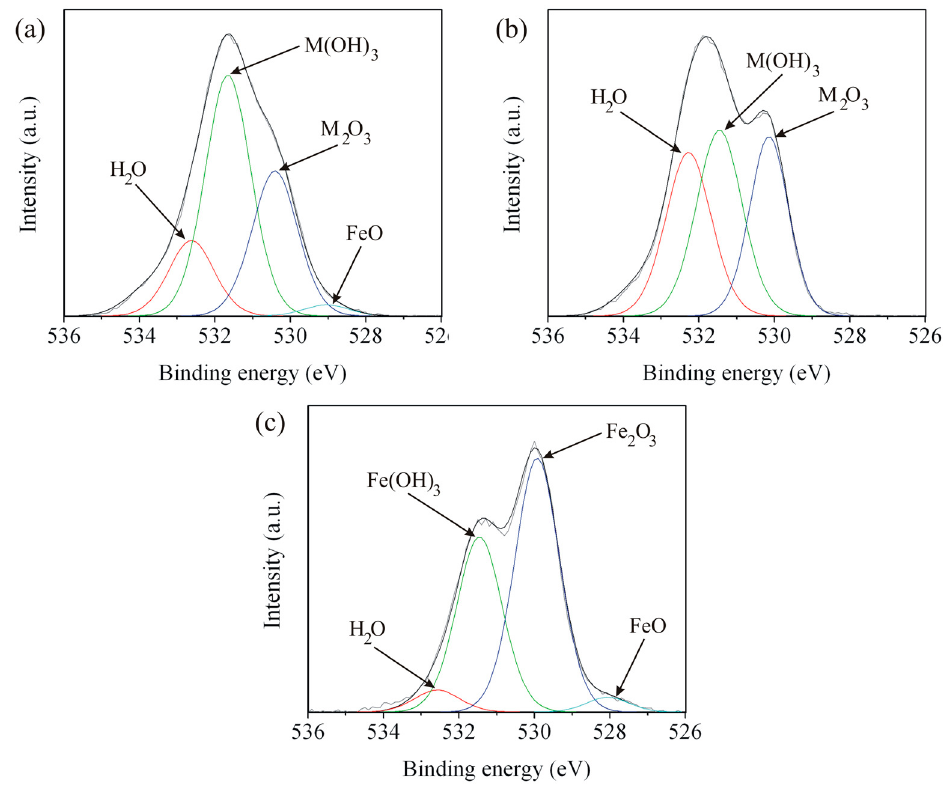
Figure 13. O 1s spectra of Zones: ( a ) A; ( b ) C; and ( c ) E.